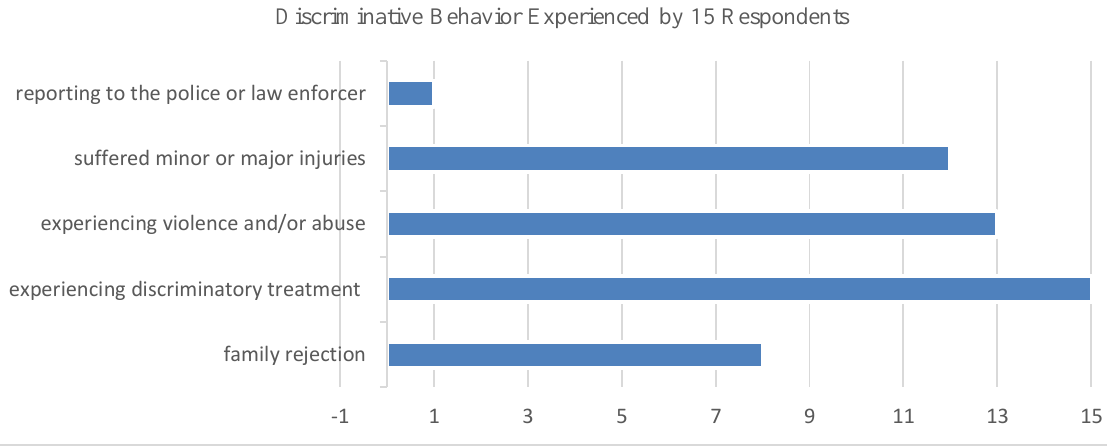
Figure 1: Discriminative Behaviors experienced by